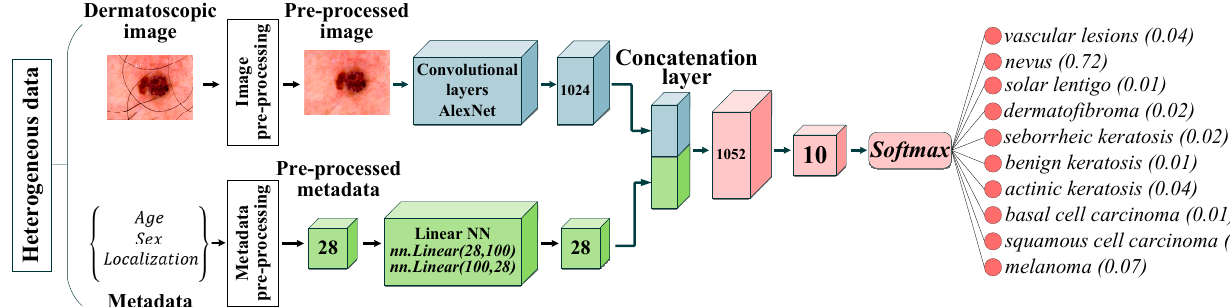
Figure 6. Neural network architecture for multimodal classification of pigmented skin lesions based on CNN AlexNet. Scale bar or magnification.